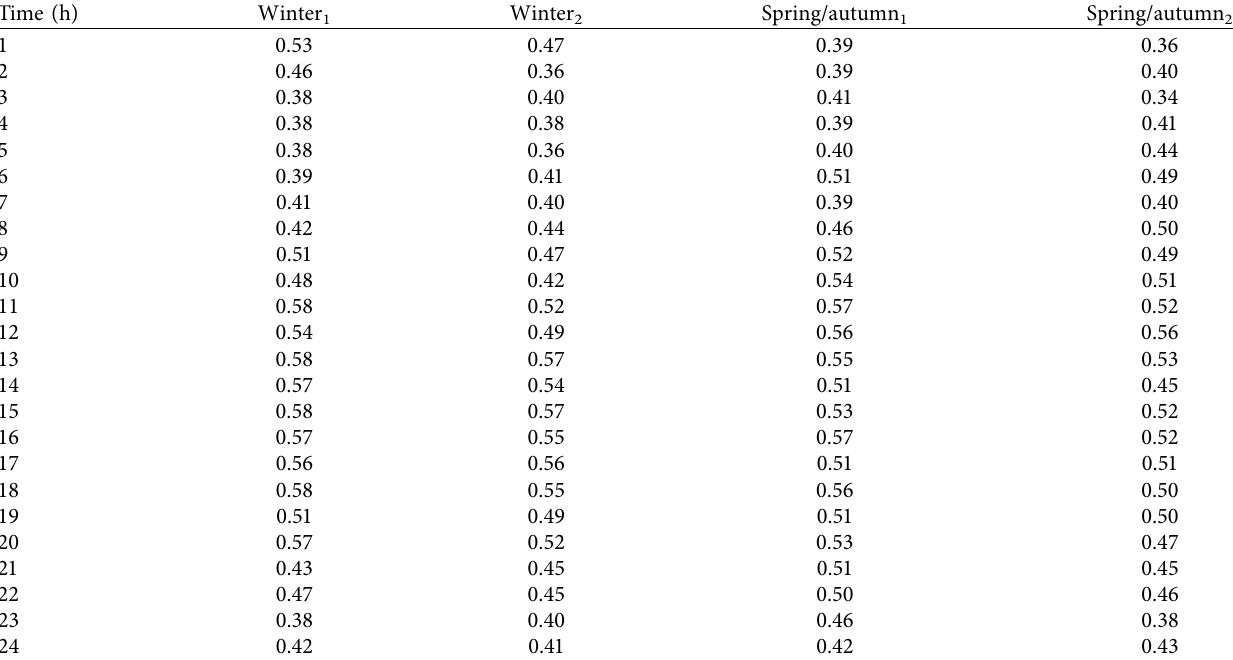
Table 4: Exergy efciency in winter and